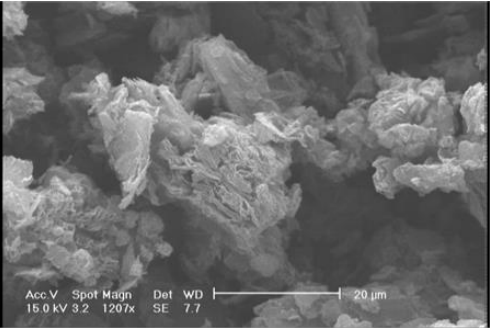
Fig. 1. SEM image of